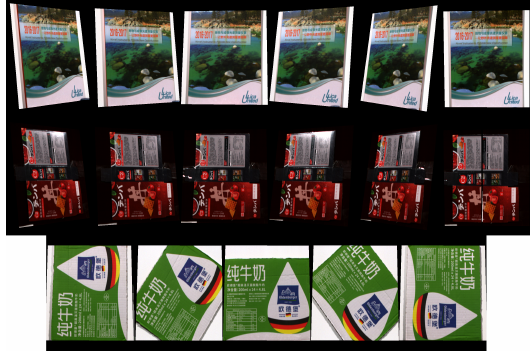
Figure 2. Pseudo-color images of the samples in the